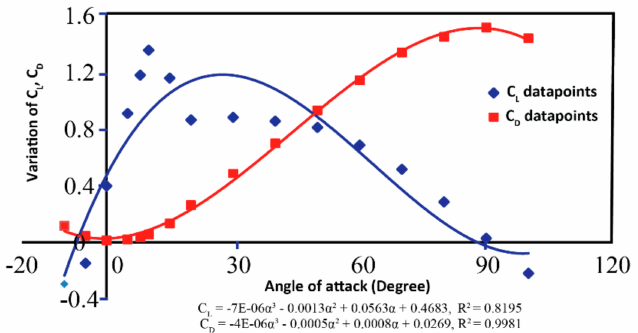
Figure 7. Variation of C L and C D with change in angle of